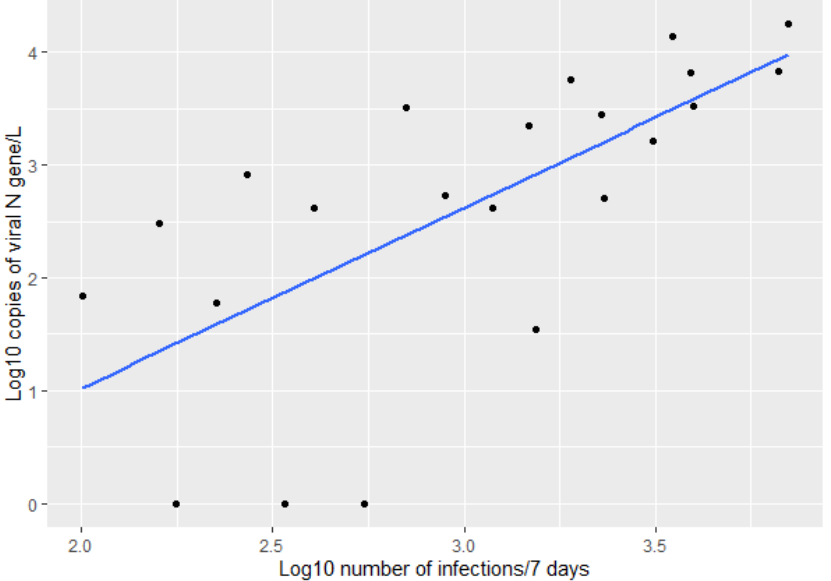
Figure 7. Correlation between the log10 transformed number of infections over the week starting on the sampling day and the log10 transformed amount of virus detected in WWTP influent (Pearson correlation = 0.681).